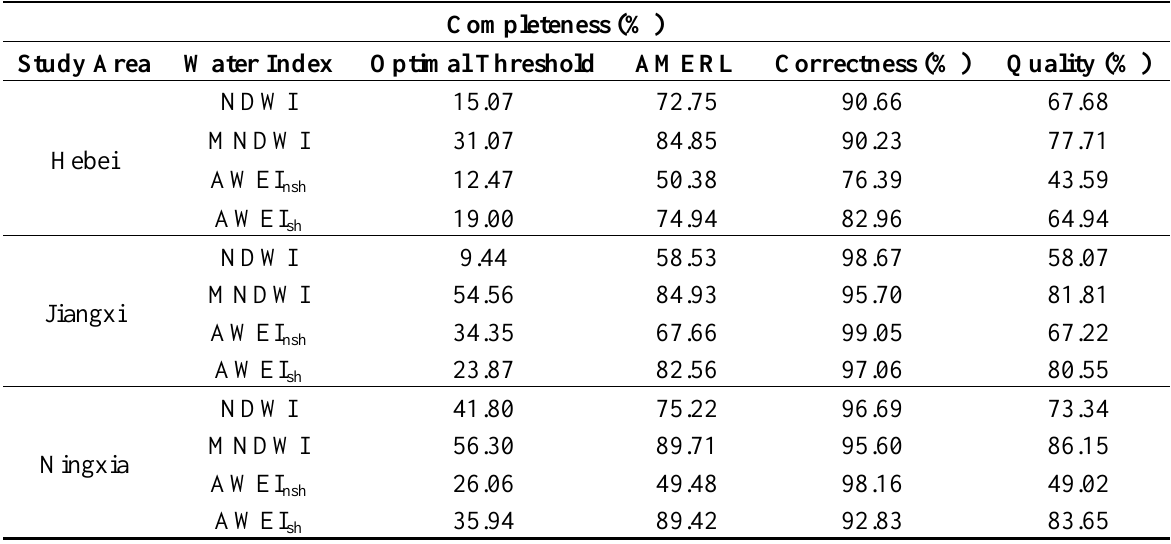
Table 6. Evaluation of the optimal thresholding method and the AMERL